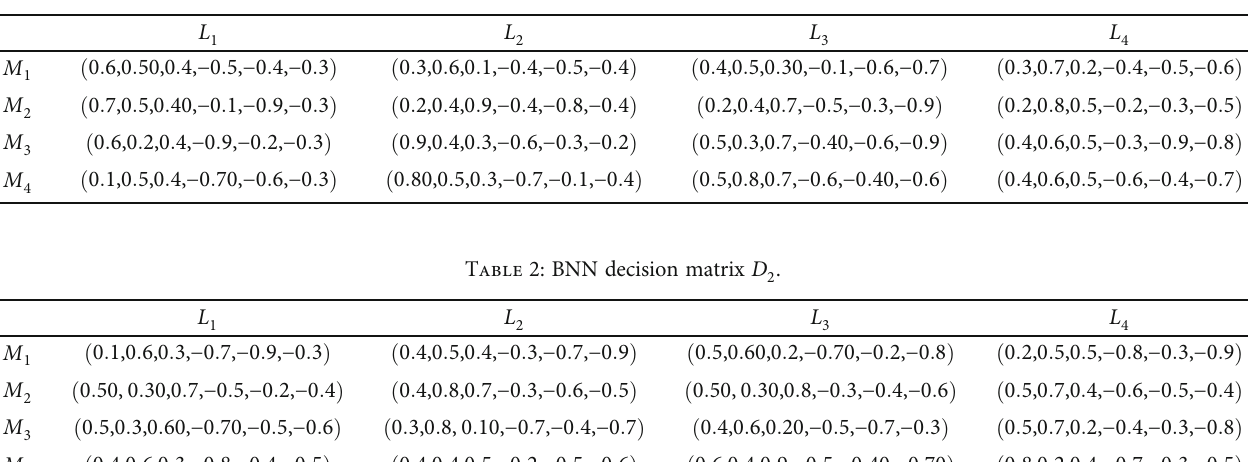
Table 3: BNN decision matrix D